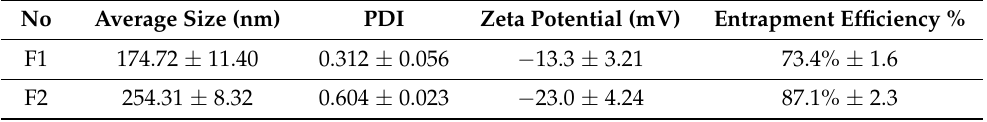
Table 1. Average particle size, polydispersity index, zeta potential, and entrapment efficiency of thymoquinone liposomal preparations (data are presented as mean ± standard error of mean, where n = 5).